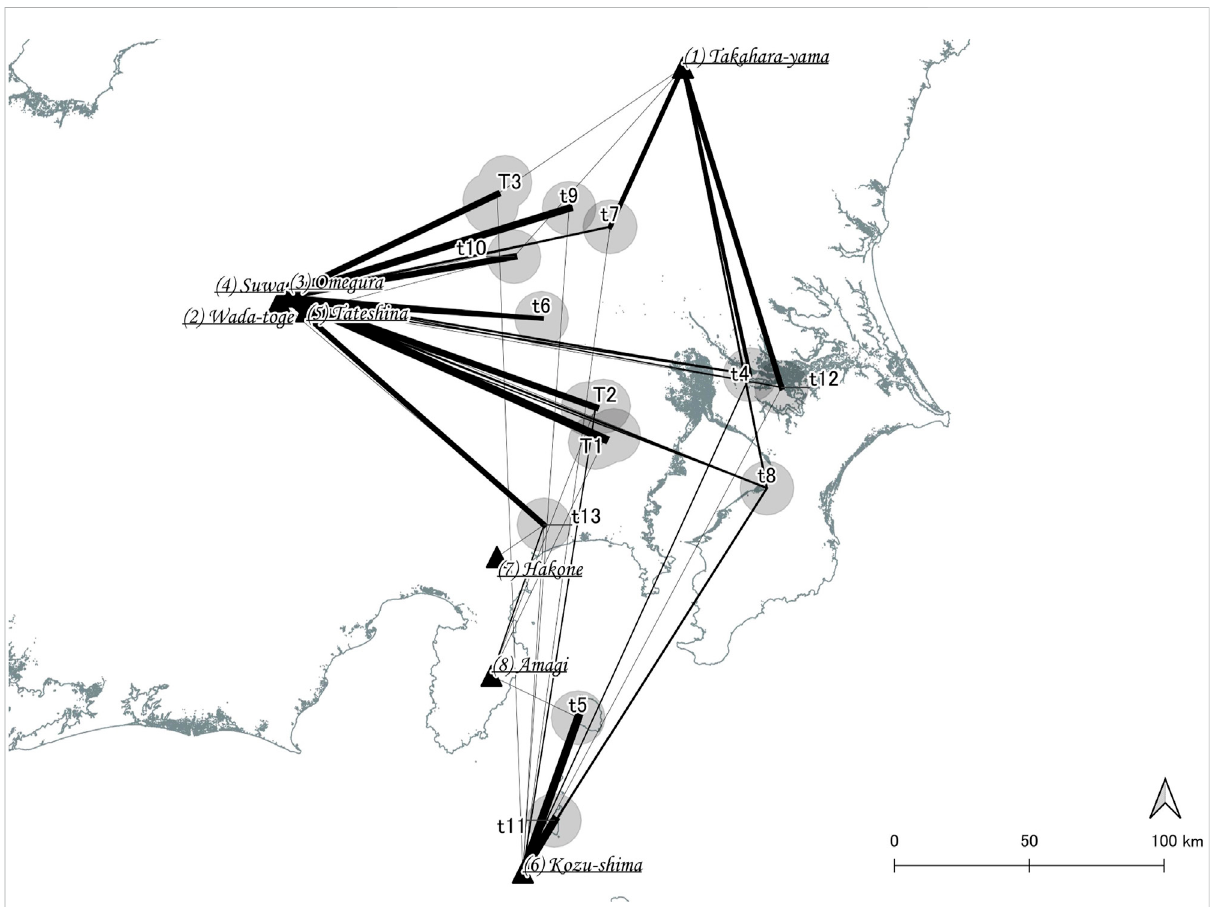
FIGURE 7 Bipartite graphs between provenance and consumption areas in Period 5, the last Jomon period (3,200 – 2,400 years cal BP). Clusters are represented by uppercase characters and single sites by lowercase characters. The thickness of the links corresponds to the composition ratio of each production area in each cluster (T1 – 3) and each single site (t4 –